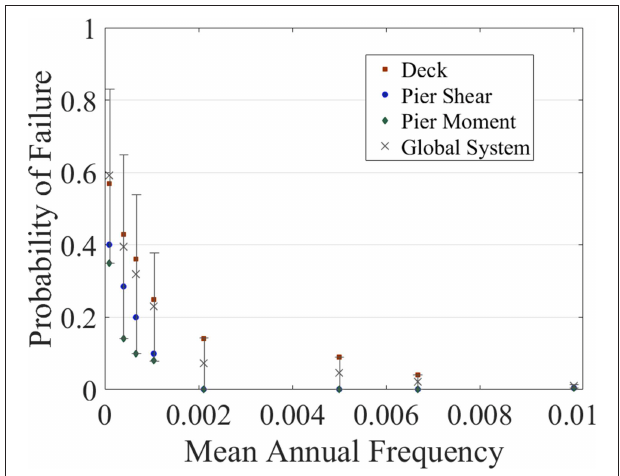
FIGURE 8 | Component and systemic probability of failure to wind hazard during hurricane